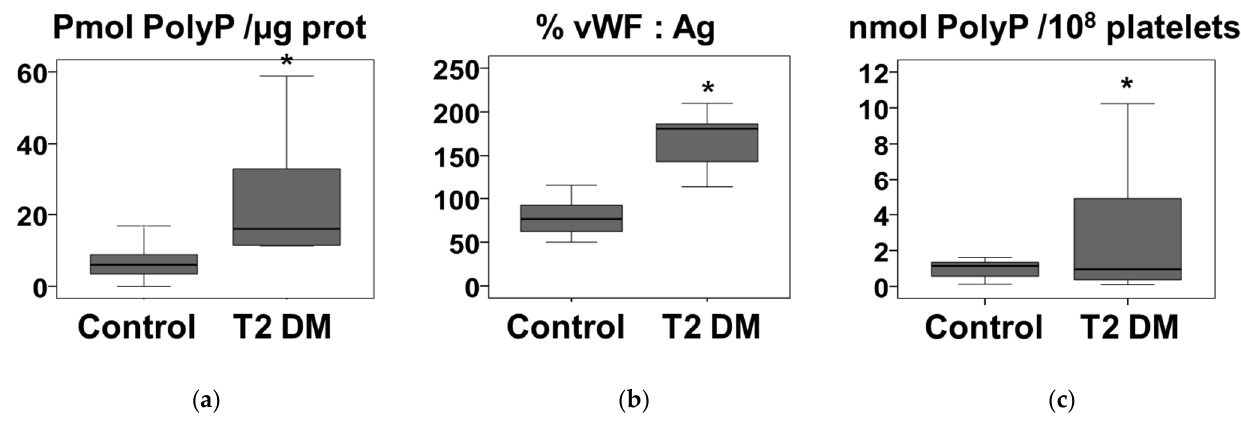
Figure 3. Increased plasma and platelet polyphosphate levels in severe type 2 diabetes. ( a ) Plasma polyphosphate (polyP) levels, ( b ) Plasma von Willebrand factor antigen (vWF:Ag), and ( c ) Platelet polyP levels were determined in 10 patients of type 2 diabetes mellitus (T2 DM) and 10 controls (described in the Materials and methods section). Results are presented in box-and whiskers plots and the asterisks indicate a statistical difference of p -value < 0.05, determined by Mann–Whitney test. Concentrations of polyP are expressed in terms of